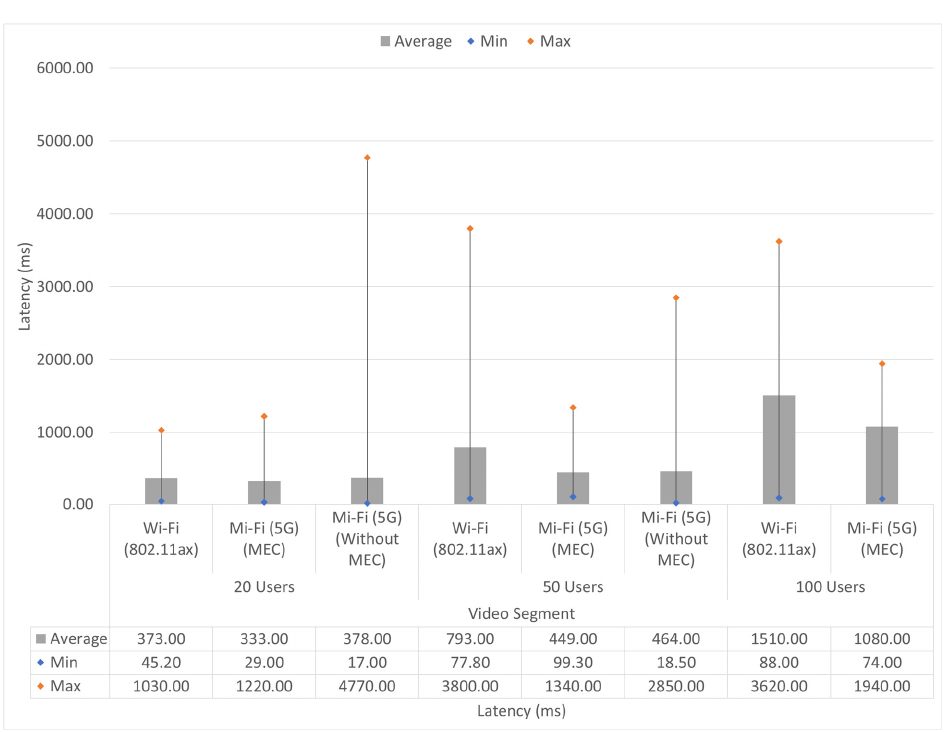
Figure 12. Load Test 5 & 10 Users Latency Result.